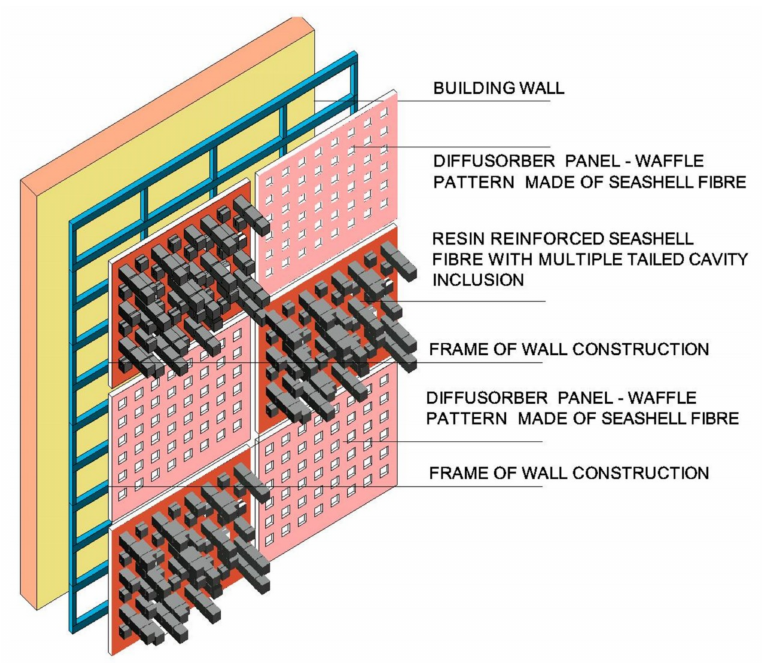
Figure 15. Mix-diffuser absorber with waffle and tailed-cavity square